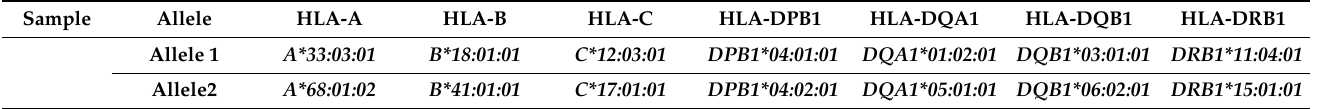
Table 3. Patient’s NGS-HLA